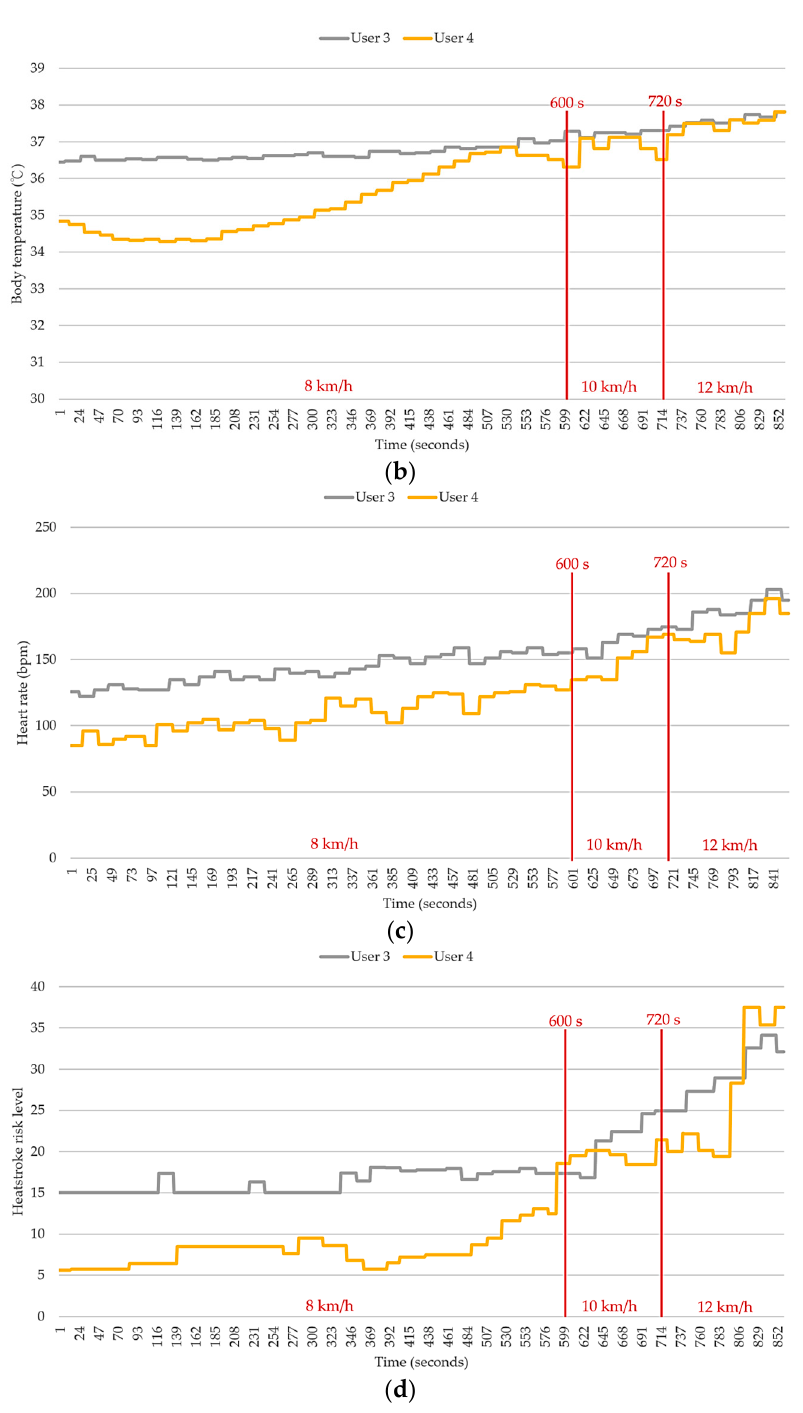
Figure 12. Comparison of skin inductance values in the testing group that reported uncomfortable conditions (user 3 and 4). ( a ) Galvanic skin response (GSR); ( b ) body temperature; ( c ) heartbeat; and ( d ) heatstroke risk level.